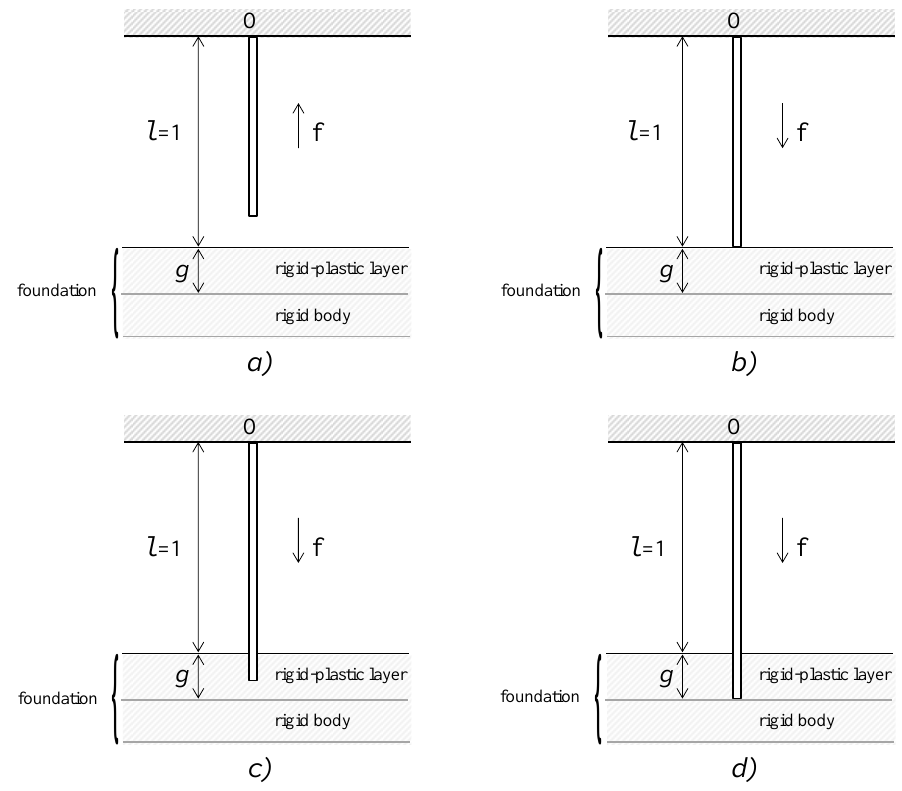
Figure 4. The four cases of contact between the rod and the foundation: ( a ) The case f < 0; ( b ) the case 0 ≤ f < 2 F ; ( c ) the case 2 F ≤ f < 2 Eg + 2 F ; ( d ) the case 2 Eg + 2 F ≤ f